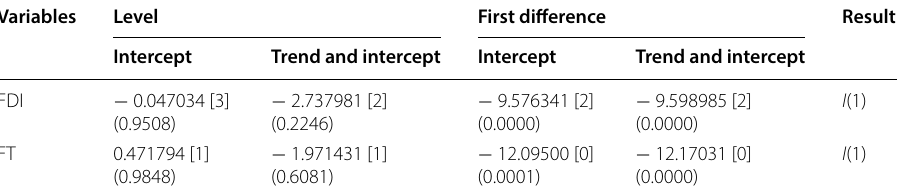
Table 2 Results of Augmented Dickey–Fuller (ADF) unit root test. Source: Calculated by authors